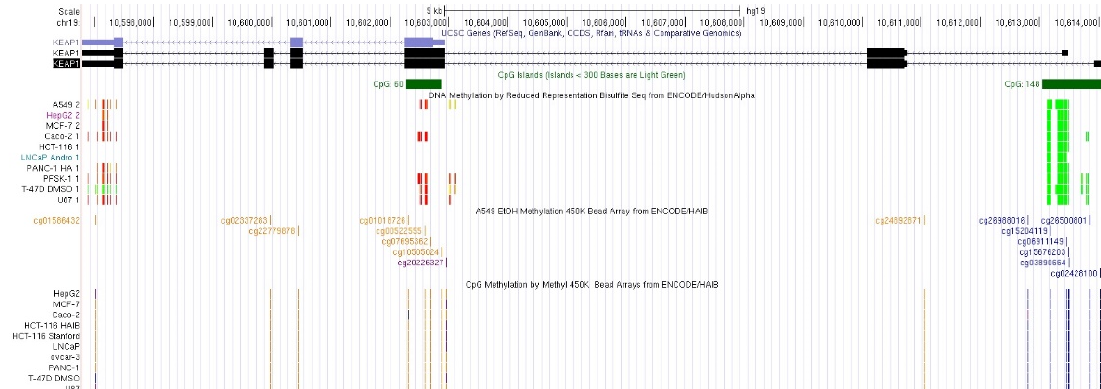
Figure 1. Schematic representation of the KEAP1 gene structure within the human hg19 genome sequence. The first reference transcript (NM_203500) is located at chr19:10596796-10614054 (strand -, 17259 bp long), while the second one (NM_012289) is located at chr19:10596796-10613481 (16686 bp long). They encode for a 624 aa protein (NCBIID: NP_987096, Uniprot ID: Q14145). Annotation and methylation data retrieved by the University of California, Santa Cruz (UCSC) Genome Browser. From top to bottom: NCBI RefSeq and Consensus CDS tracks for KEAP1 exon/intron structure; predicted CpG islands (“Regulation” >> “CpG Island” track); detected methylation sites (“Regulation” >> “ENCODE DNA Methylation tracks” >> “DNA Methylation by Reduced Representation Bisulfite Seq from ENCODE/Hudson Alpha” and “CpG Methylation by Methyl 450K Bead Arrays from ENCODE/HAIB”. Methylation status of genomic sites is represented through a color gradient vertical bars. Red-orange bars indicate strong methylation signals (i.e., a high relative number of methylated molecules vs. unmethylated molecules in bisulfite sequencing experiments); orange and blue bars indicate strong methylated vs. unmethylated status in 450K array experiments.